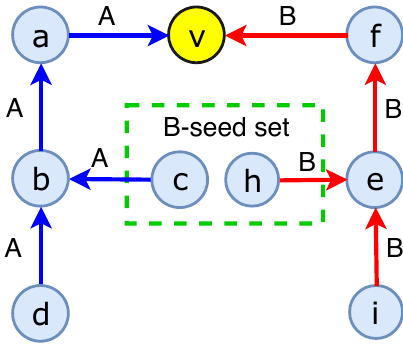
Figure 5. Description for C L ( g , v )